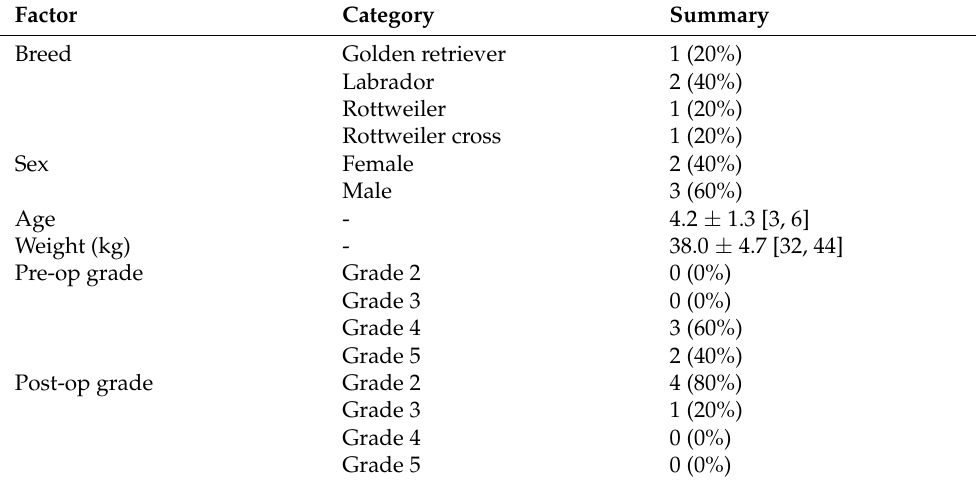
Table 1. Summary of study